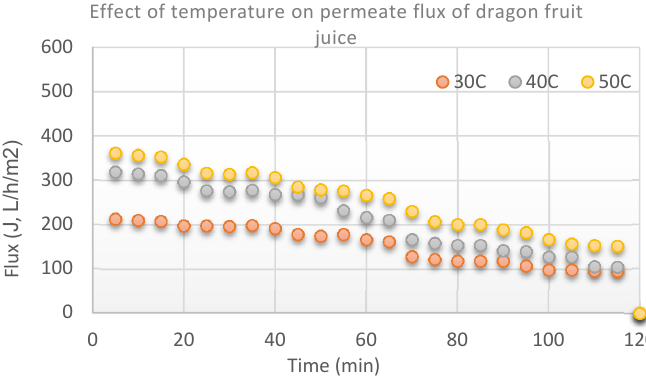
Figure 11. Effect of temperature on permeate flux of dragon fruit juice (TMP = 3 bars; membrane = 1000 nm).